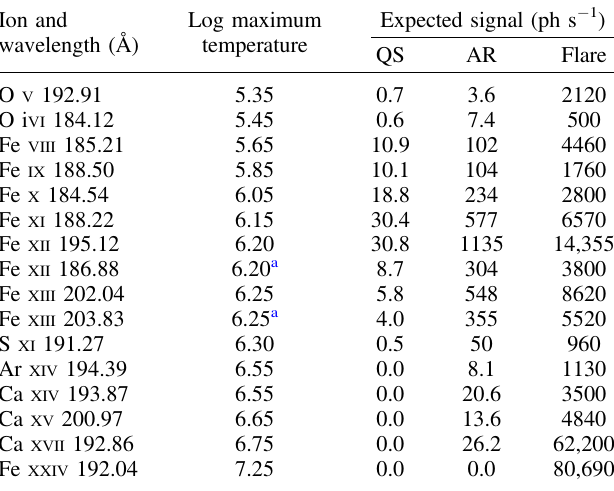
Fig. 5. The dual-channel COSIE design uses a rotating fl ip mechanism to select between the wide- fi eld imager COSIE-C channel (left) and the slitless spectrograph COSIE-S channel (right). Solar EUV enters from the upper left, as indicated by the blue arrows, with visible light blocked by a thin Al entrance fi lters. Light then re fl ects from the rotatable fl ip mechanism selector onto a multilayer-coated focusing optic that is alternately used by both channels. Table 1. Strong lines in the COSIE-S wavelength